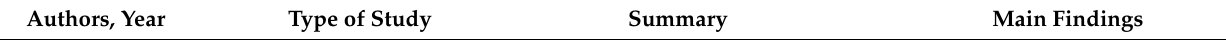
Table 2. Characteristics and summary and main findings of the analysed clinical